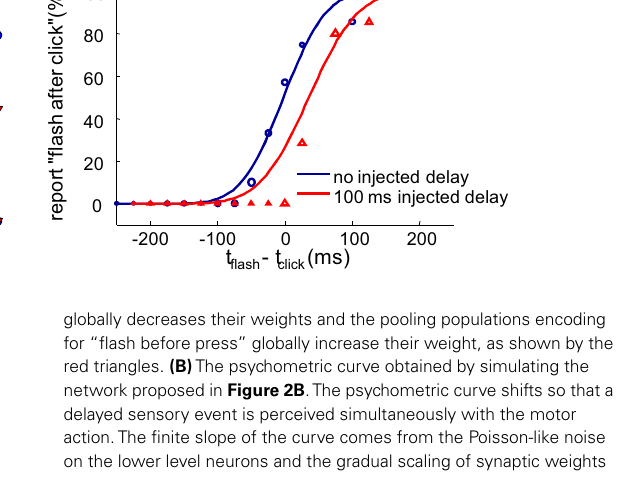
globally decreases their weights and the pooling populations encoding for “flash before press” globally increase their weight, as shown by the red triangles. (B) The psychometric curve obtained by simulating the network proposed in Figure 2B .The psychometric curve shifts so that a delayed sensory event is perceived simultaneously with the motor action.The finite slope of the curve comes from the Poisson-like noise on the lower level neurons and the gradual scaling of synaptic weights after a constant injected